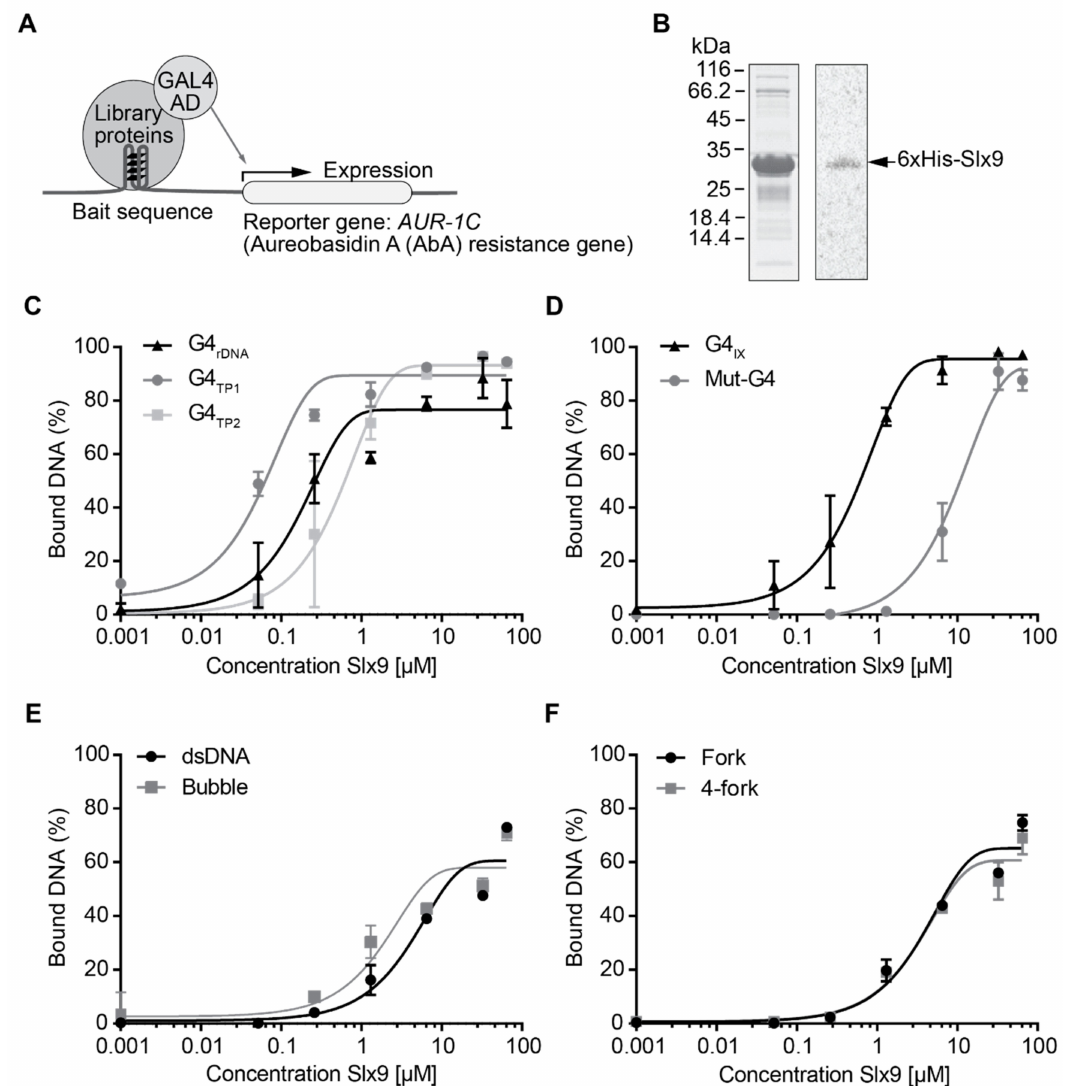
Figure 1. Slx9 is a novel in vitro G4-binding protein. ( A ) Illustration of the yeast one-hybrid screen experimental setup. ( B ) Coomassie staining and Western blot analysis of purified Slx9 protein. The Western blot was performed using an anti-His antibody. 6 × His-Slx9 (30 kDa) was detectable between the 25 and 35 kDa marker (arrow). ( C ) Quantification of Slx9 binding to di ff erent G4 structures by filter-binding assay, plotted in log scale. Slx9 shows binding to all tested G4 structures with K d values of 0.55 ± 0.08 µ M (G4 IX ), 0.21 ± 0.04 µ M (G4 rDNA ), 0.04 ± 0.01 µ M (G4 TP1 ), and 0.53 ± 0.10 µ M (G4 TP2 ). ( D ) Slx9 binding to a G4 structure from a selected region of chromosome IX (black) and a mutated version of this G4 motif which cannot fold G4 structures but is 95% identical (grey). ( E , F ) Slx9 binding to other DNA structures such as dsDNA, bubble, forked, and 4-fork substrates. Slx9 showed less a ffi nity to the tested control DNA structures: K d 15.69 ± 3.57 µ M (G4 mut ), 5.27 ± 1.18 µ M (dsDNA), 1.73 ± 0.42 µ M (bubble), 4.21 ± 0.64 µ M (fork), 3.72 ± 0.62 µ M (4-fork). Plotted results were based